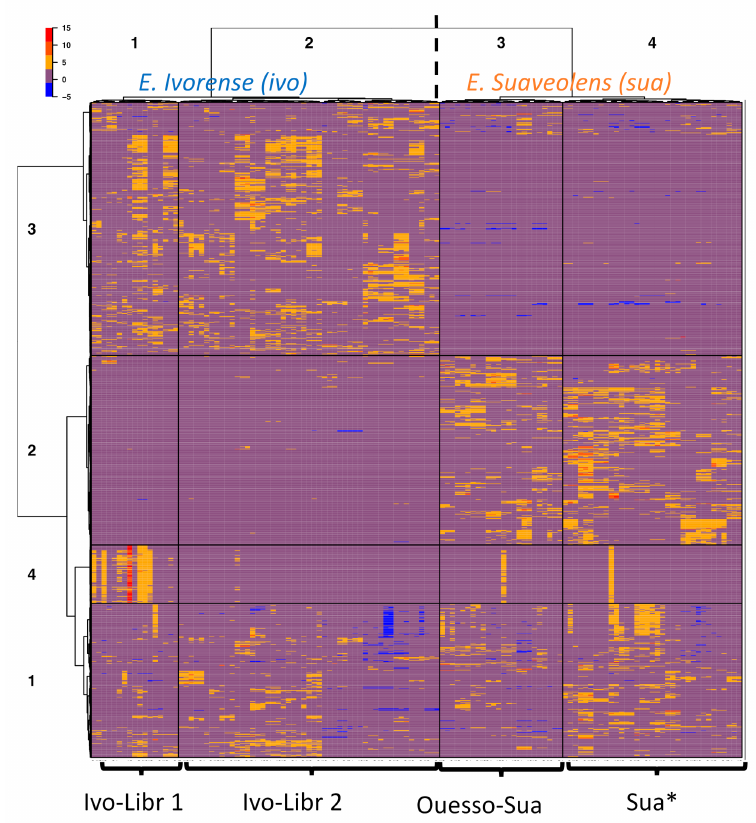
Figure 3. Heatmap clustering representation of metabolic diversity in two Erythrophleum species. Samples are in columns and features in rows. Hierarchical clustering splits E. ivorense (ivo) into 2 clusters named ivo-Libr 1 (=cluster 1) & ivo-Libr 2 (=cluster 2), and E. suaveolens (sua) is splitted into 2 clusters named Ouesso-Sua (=cluster 3) and Sua * (=cluster